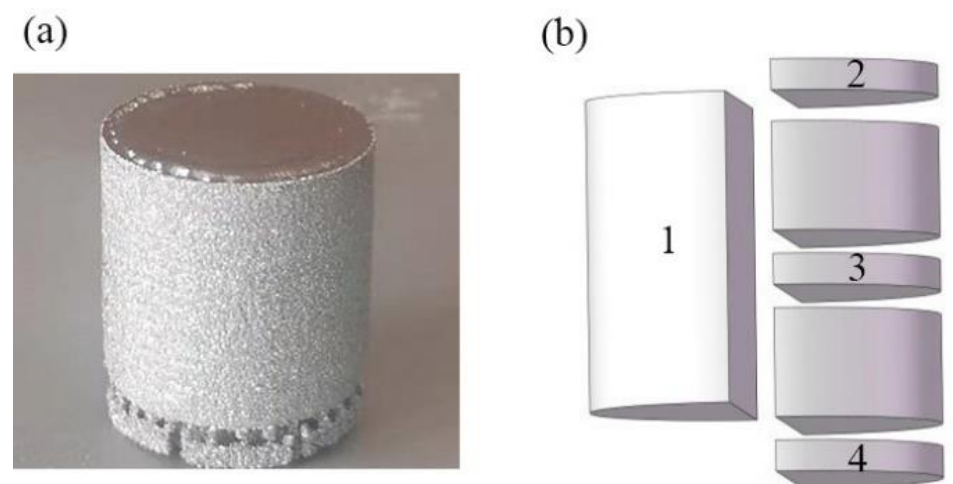
Figure 2. ( a ) Ti2448 sample manufactured by PBF-EB. ( b ) Sketch illustrating how the sample was sectioned for metallo- graphic analysis. (Position-2, 3 and 4 is 18 mm, 10 mm and 2 mm from the base plate, respectively).